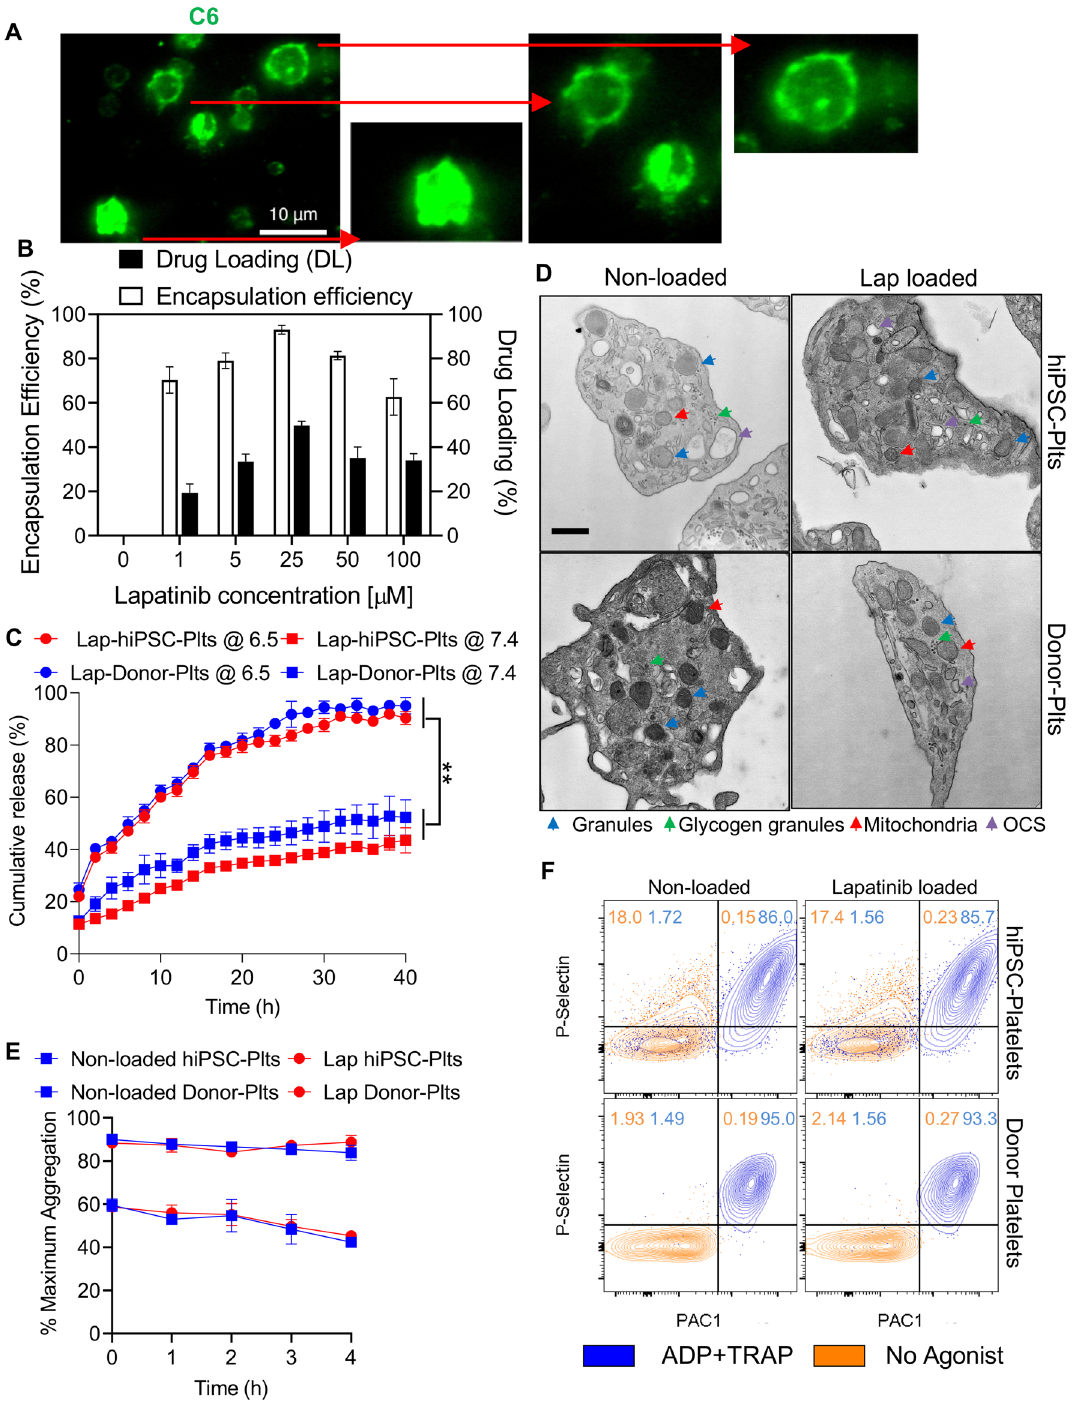
Figure 2. Functionality characterization and comparison of lapatinib-loaded hiPSC-platelets to non-loaded hiPSC-platelets. (A) Fluorescence image of hiPSC-platelets under an oil immersion lens (×100), demonstrating the in vitro cellular uptake of fluorescent C6 (green). Scale bars = 10 µm. Inset zoomed in images of individual C6-loaded hiPSC-platelets are shown on the right. (B) Encapsulation efficiency and drug loading capability of lapatinib-loaded hiPSC-platelets with different concentrations of lapatinib (means ± SD, n = 3). ** indicates p < 0.01. (C) Analysis of lapatinib release kinetics from hiPSC- and donor-derived platelets in PBS at pH values of 6.5 and 7.4 at 37 °C over 40 h. (D) Transmission electron micrograph of non-loaded hiPSC and donor-derived platelets and platelets loaded with 25 µM lapatinib. Colored arrows indicate organelles: blue, granules; green, glycogen granules; red, mitochondria; and violet, OCS. Scale bar = 400 nm. (E) LTA-based aggregation assays of non-loaded and 25 µM lapatinib-loaded hiPSC- and donor-derived platelets stimulated with 20 µM ADP and 20 µM TRAP, showing time-dependent variability (mean ± SD, n = 3). (F) Representative flow cytometry (Fortessa) plots showing the surface PAC1 and P-Sel activation of non-loaded and 25 µM lapatinib-loaded hiPSC- and donor-derived platelets by 20 µM ADP and 20 µM TRAP. Orange contour plots represent unstimulated platelets, and blue contour plots represent platelets activated upon exposure to ADP and